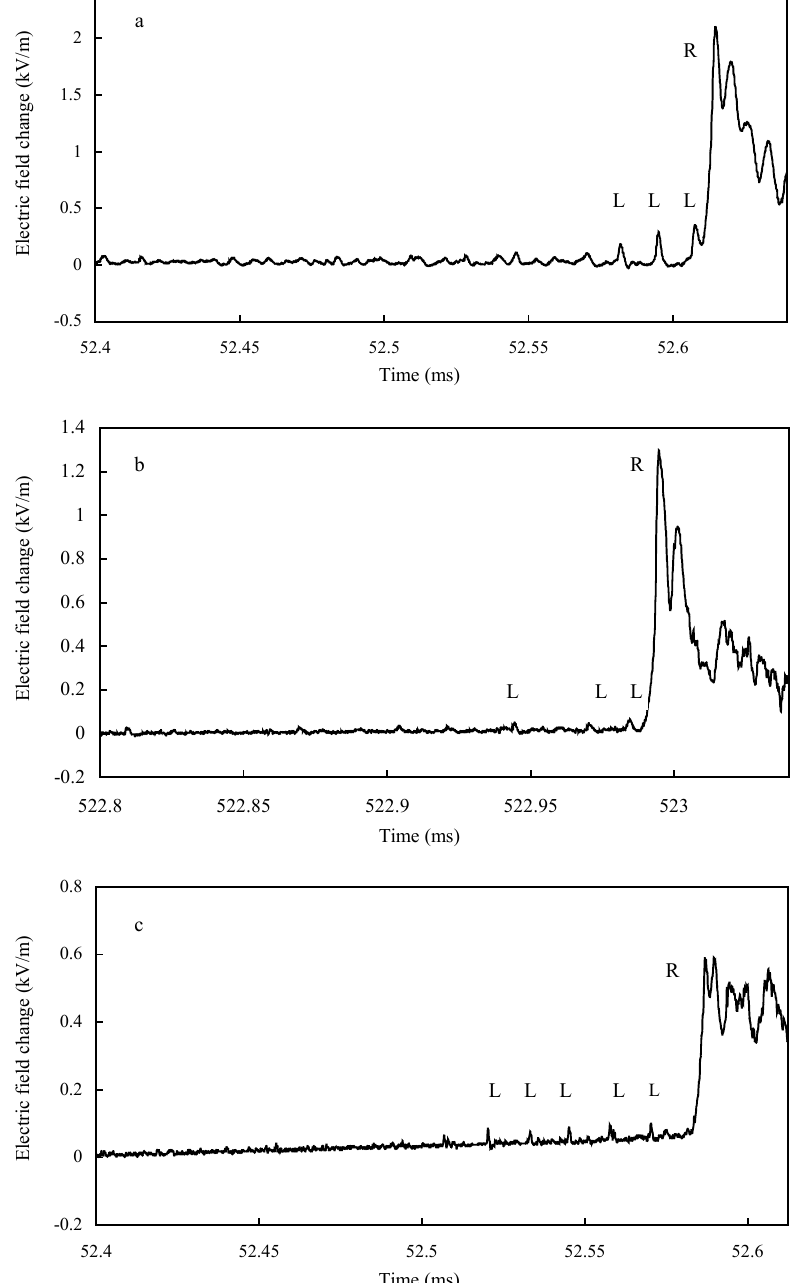
in Figs. 3a–c. The first return stroke is marked with R , and the leader pulses are marked with L . All of the three negative discharges occurred in the same thunderstorm. The first type is characterized by a small pulse superimposed on the abrupt beginning of the return stroke, as shown in Fig. 3a, and ac- counts for 42% of all the cases. The second type, as shown in Fig. 3b, accounts for 33.3% of all the cases, and is char- acterized by relatively smooth electric field changes between